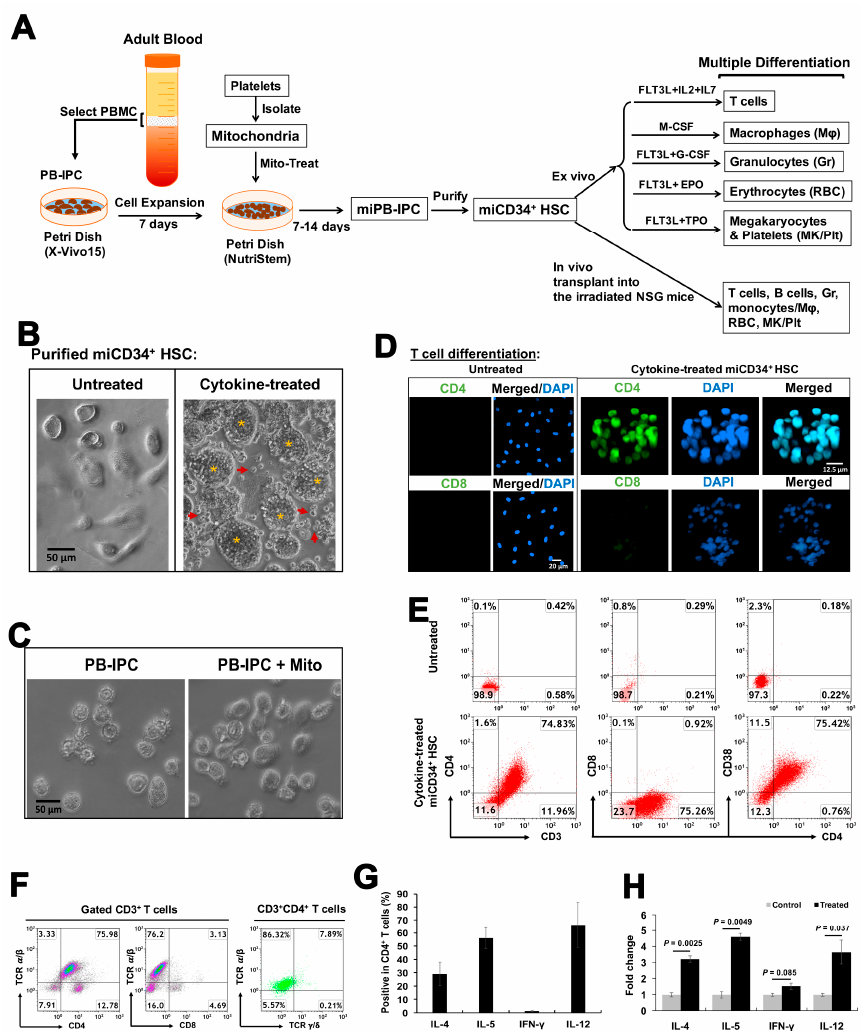
Figure 2. In vitro differentiation of purified miCD34 + HSCs to T cells. ( A ) Outline of the whole protocol from the generation of miPB-IPCs to multipotent cellular differentiations of miPB-IPCs. The miCD34 + HSCs were purified for in vitro and in vivo differentiations, respectively. ( B ) Phase-contrast images showing T-cell differentiation of purified miCD34 + HSCs in the presence of FLT-3 ligand, IL-2, and IL-7 for 3 days ( n = 4). Untreated cells served as a control (left). The treated-CD34 + HSCs displayed substantial morphological changes with cell clusters (orange stars), and some floating cells (red arrows) released from “cell clusters” (orange stars). Magnification ×200. ( C ) Phase-contrast images show the morphology of control PB-IPCs (left) and treated PB-IPCs in the presence of mitochondria (right) ( n = 4). Original magnification: ×200. ( D ) Z-stacked confocal images demonstrated strong expression of human T-cell marker CD4 with a low expression of CD8 ( n = 4). Untreated miCD34 + HSCs served as control for immunostaining (left panel). ( E ) Flow cytometry revealed that differentiated T cells were CD3 + CD4 + CD8 − CD38 + ( n = 4). Untreated miCD34 + HSCs served as controls (top panel). ( F ) Expression of T-cell receptors α / β (TCR αβ ) in the gated CD3 + and CD4 + T cells ( n = 4). ( G ) Intracellular staining of differentiated T cells with Th1/Th2 cell cytokine markers ( n = 3). Isotype-matched IgG served as a control. Data are presented as mean ± SD from three experiments. (H) Fold-changes of cytokine expression levels in the in vitro differentiated T cells after the stimulation with PMA and ionomycin ( n = 3). Data represent mean ± SD.